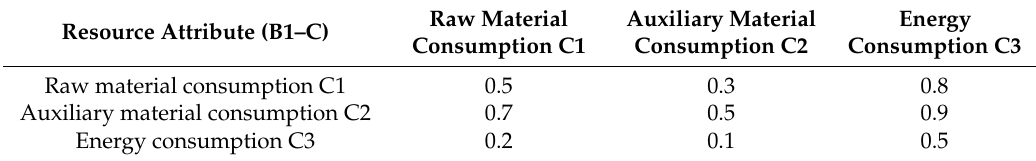
Table 5. Layer judgment matrix